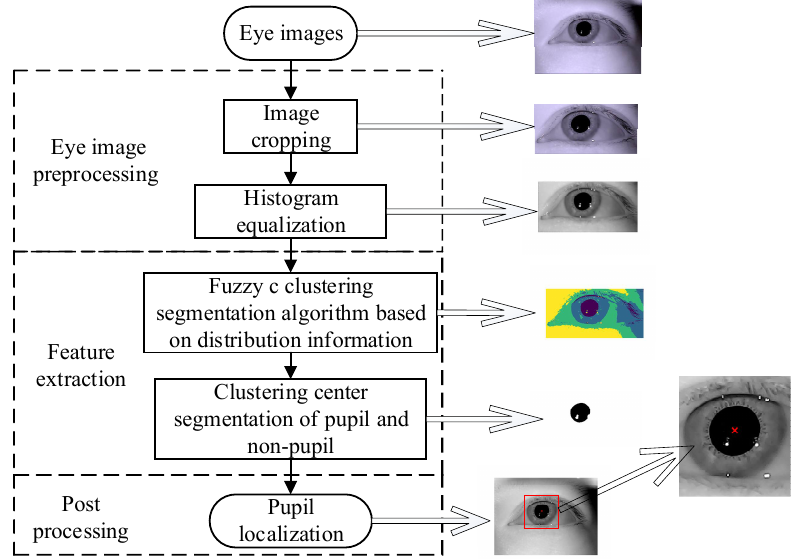
Figure 1. Flow chart of the pupil detection in this article. First, eye image preprocessing, as described in Section 2.2. Second, feature extraction, as described in Sections 2.3 and 2.4: the fuzzy c clustering algorithm based on distribution information is used to obtain the cluster center of pupils and non-pupils. Then, we compare the size of the clustering center to get pupil cluster center. Finally, postprocessing, as described in Section 2.5: we detect the pupil region to obtain the location of the pupil in eye image.